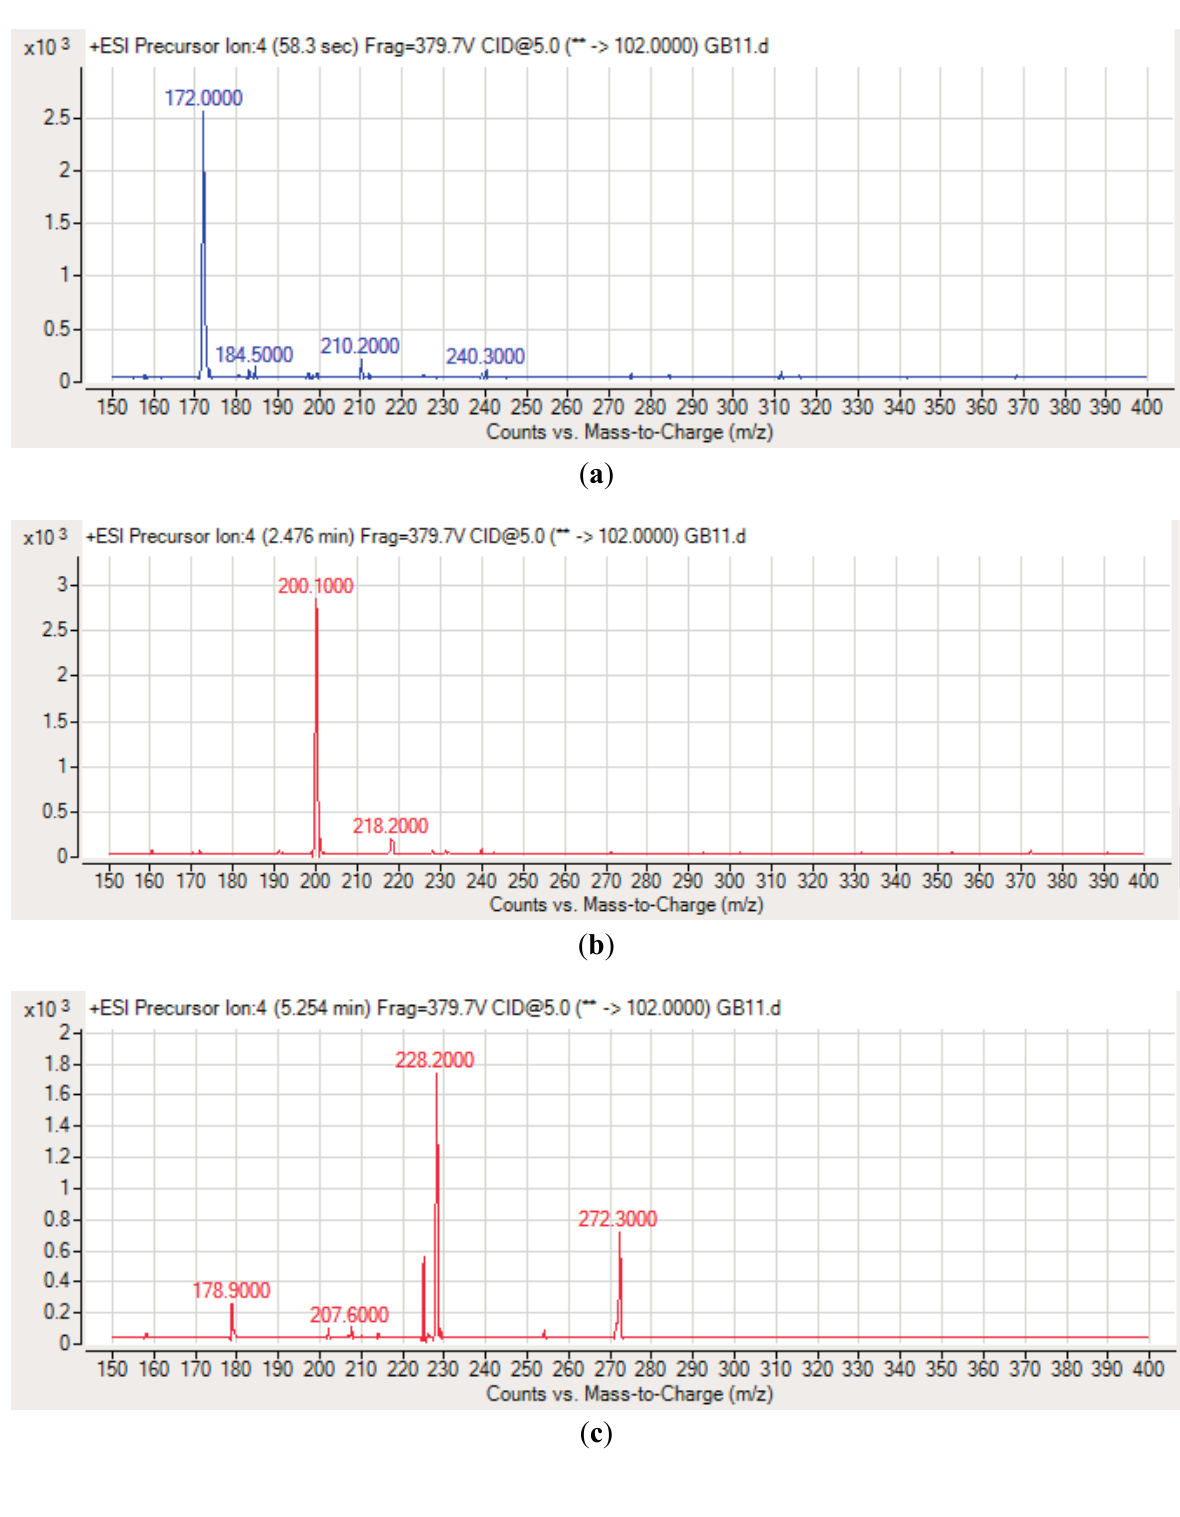
Figure 5. Mass spectrometry analysis of AHLs produced by Pseudomonas